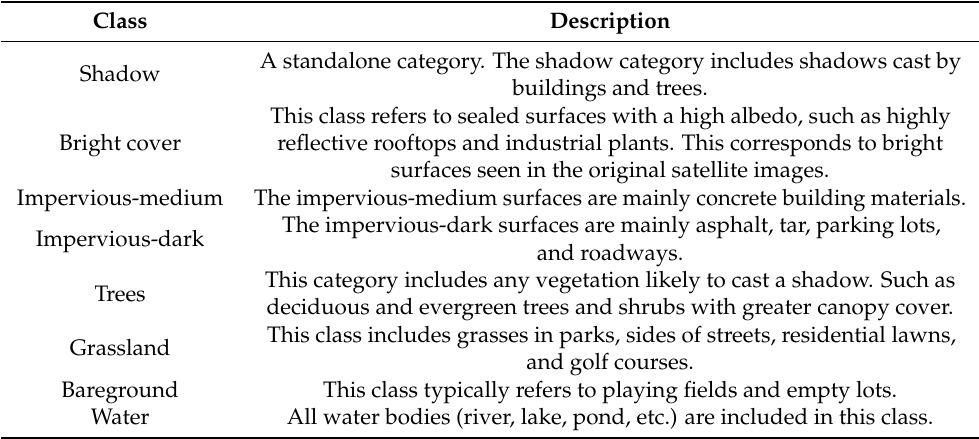
Table 2. The land-use categories are delineated based on the spectral signature using Fuzzy ARTMAP [33].